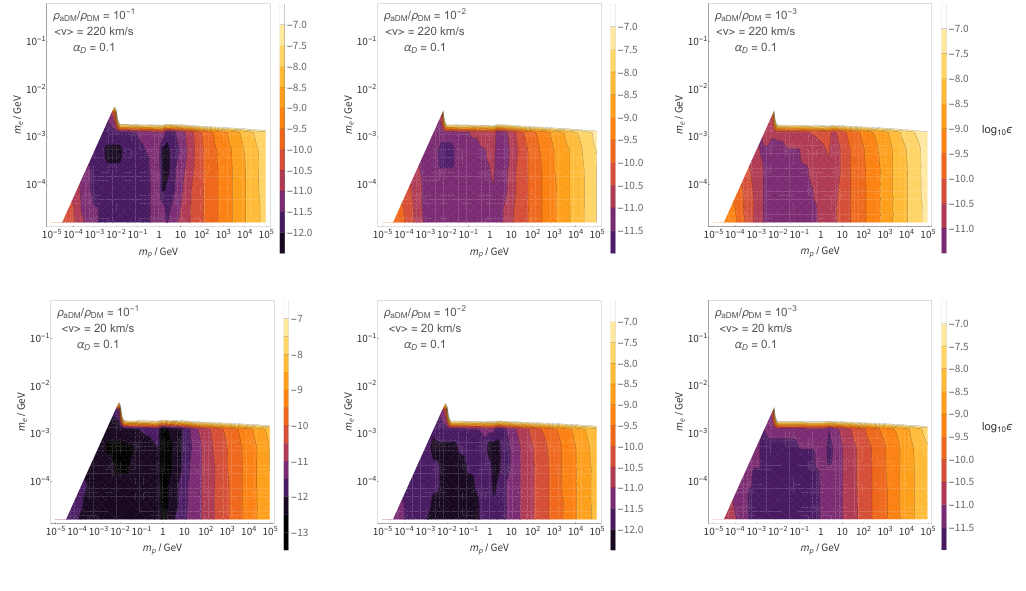
Figure 8 . Same as figure 5 but for α D = 0 . 1 .